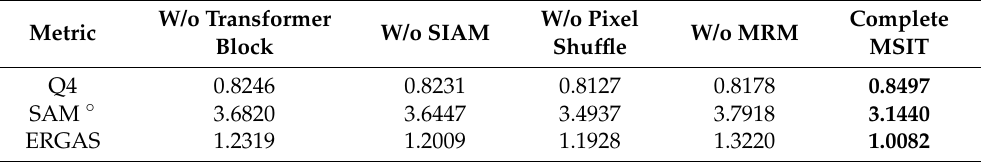
Table 6. Numerical evaluations of the fused images in Figure 9 (GeoEye-1 dataset).